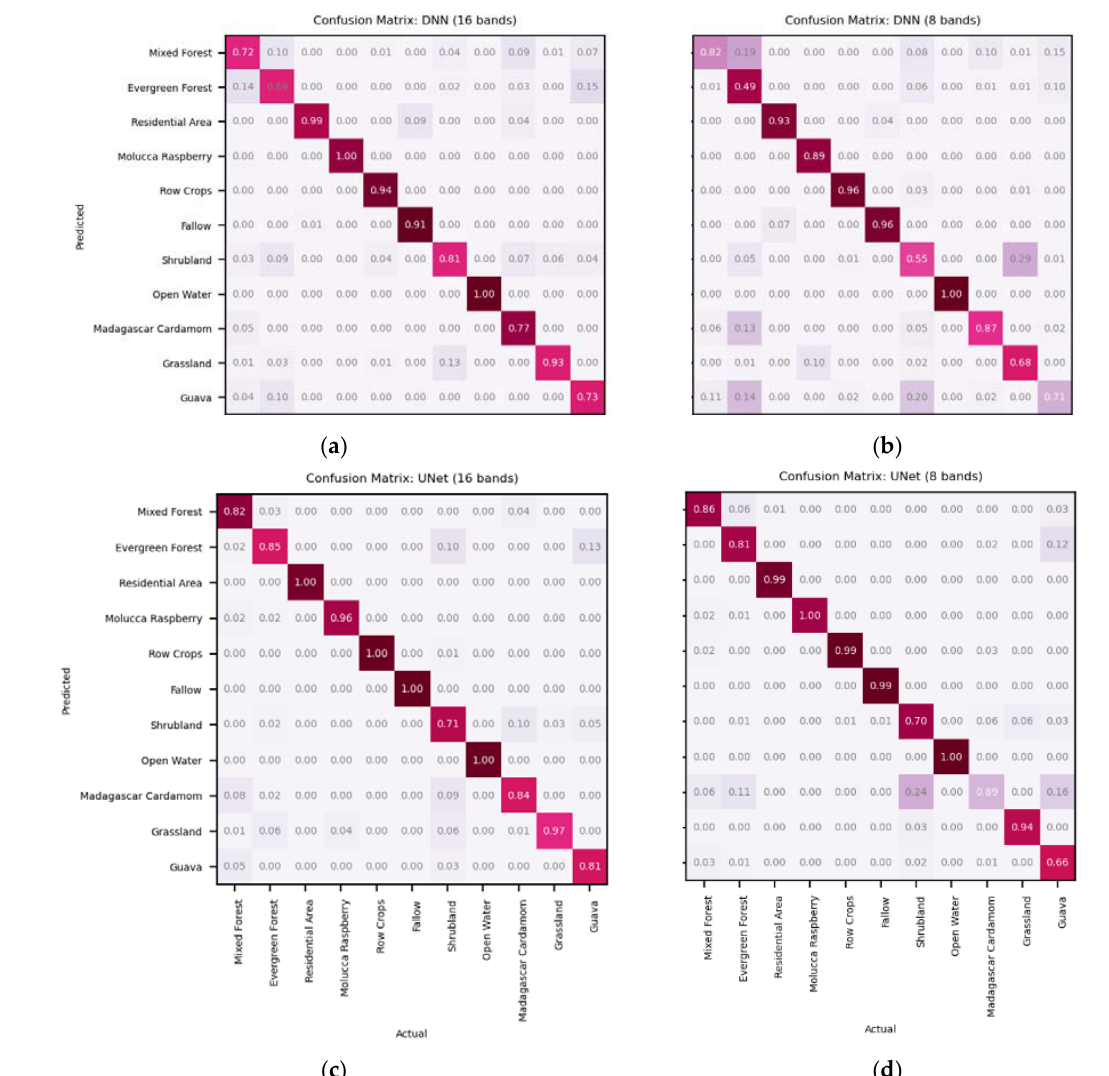
Figure 6. Comparison of confusion matrixes for ( a ) DNN where SWIR bands were included, ( b ) DNN where SWIR bands were excluded, ( c ) U-Net where SWIR bands were included, and ( d ) U-Net where SWIR bands were excluded. A greater number of FPs and FNs are seen in ( b , d ) because of the removal of the SWIR bands. The DNN and U-Net models are chosen for comparison because of the highest and lowest reduction in accuracy due to the removal of SWIR.